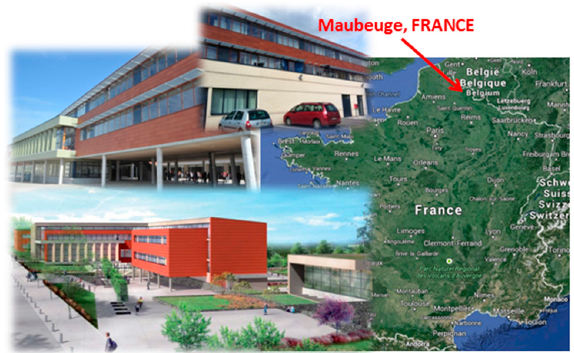
Figure 1. Picture and location of the junior high school investigated in this work. The city of Maubeuge (North of France, 50°16 ′ 39 ″ North, 3°58 ′ 24 ″ East) has about 31,000 inhabitants.